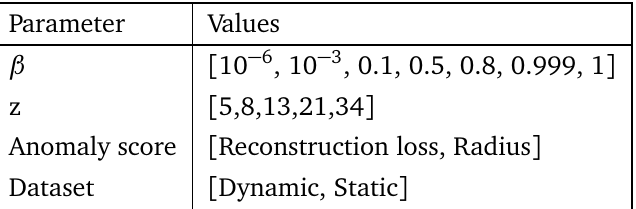
Table 7: All hyperparameters used to train the various β -VAE